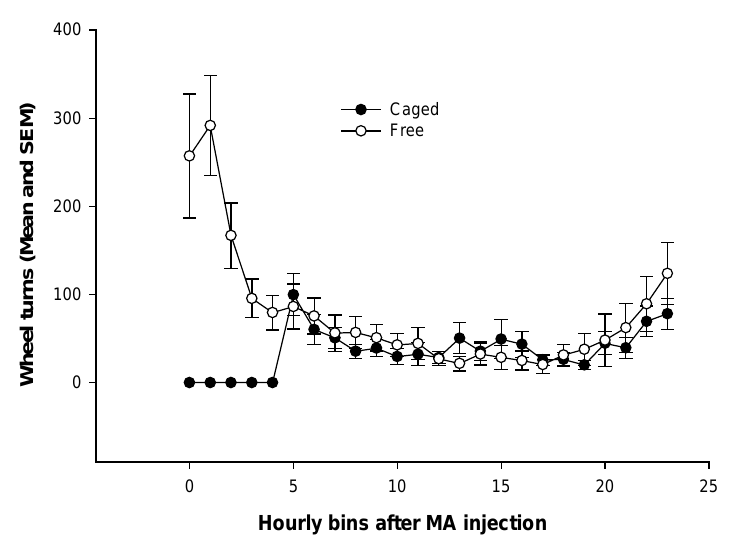
FIGURE 2. Wheel running (Mean ± SEM) in seven rats given injections of MA (2 mg/kg) at 24-h intervals. Following a series of 26 saline injections (data not shown), rats were given 20 injections of MA and then confined to small cages for 5 h, to prevent the sustained intense wheel running that normally follows MA administration. Following the Caged phase, the rats were given 16 more injections of MA and allowed free access to the running wheel (phase Free). Data for each subject were smoothed using a 1-h moving average, summed into 1-h bins, and averaged across animals. The rats were housed without time-of-day cues, under constant dim lighting, and with rate- limited feeding. MA was administered at time 0, and both groups showed anticipatory wheel running at hours 22 and 23. This result suggests that the locomotor activity directly stimulated by MA is not required for circadian anticipation.